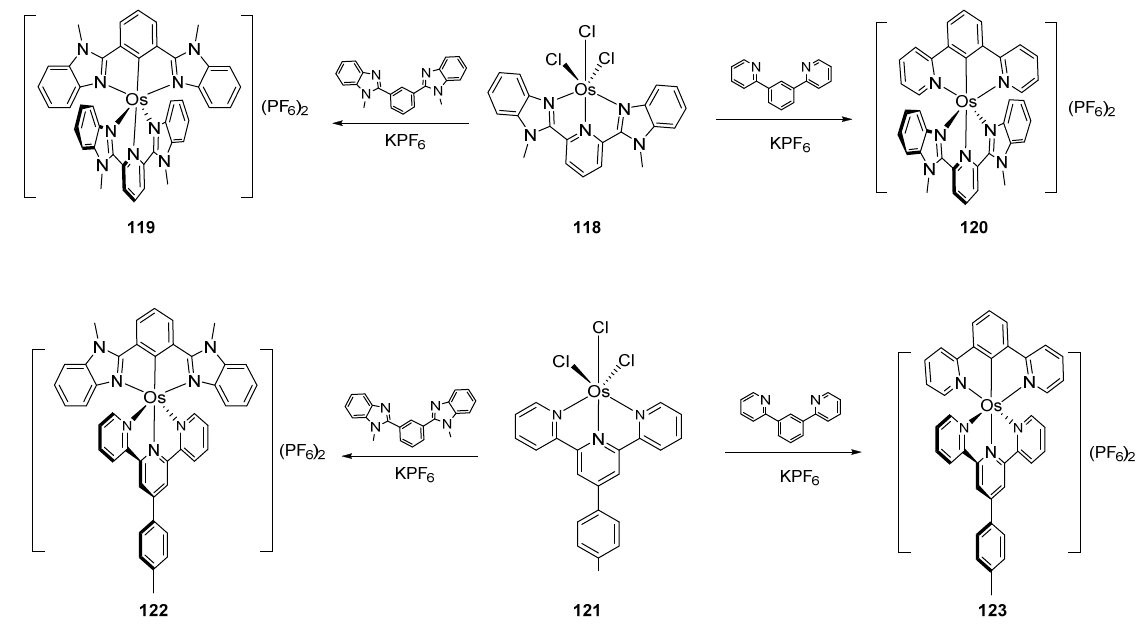
Figure 26. Synthesis of bis -pincer complexes.